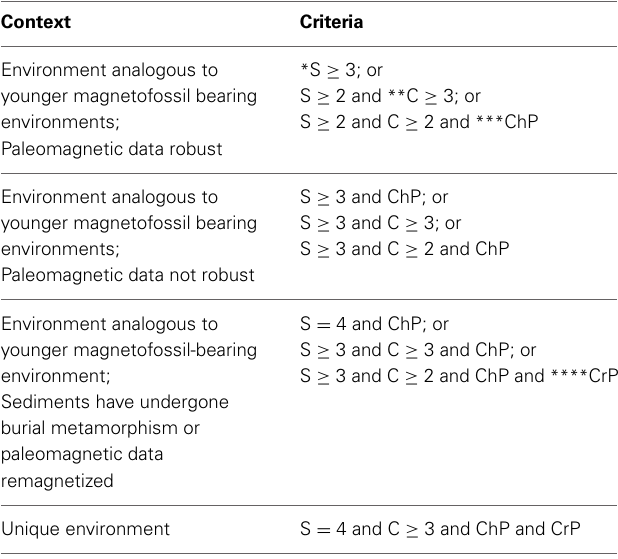
Table 1 | Proposed magnetofossil robustness criteria (Kopp and Kirschvink,